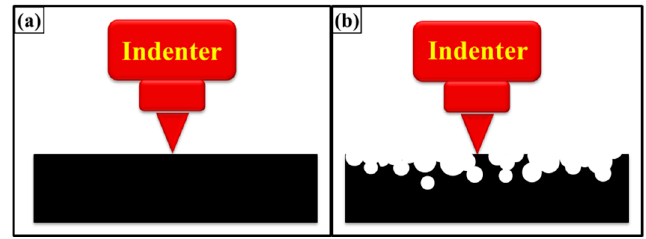
Figure 19. Indenter pressed against: ( a ) smooth; ( b ) rough surfaces. Figure 20. Indenter pressed against: ( a ) smooth; ( b ) rough